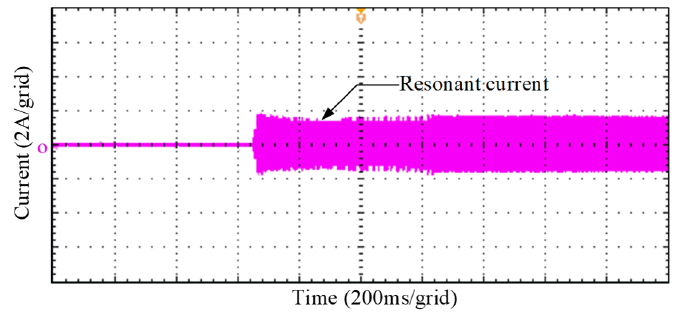
Figure 33. Soft-start process with resonant current.